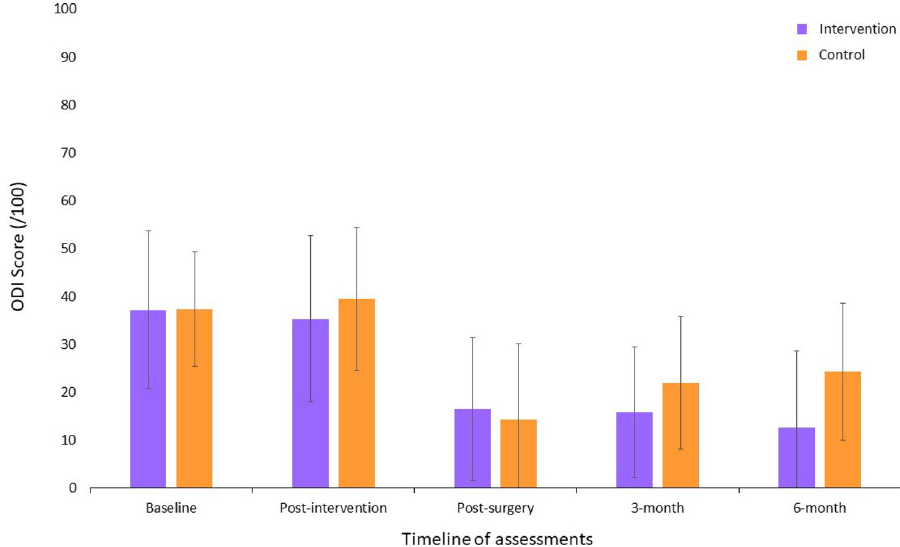
Figure 2. Comparison of low back related disability (means ± SD) (Greater scores indicate greater disability; ODI Oswestry disability index).